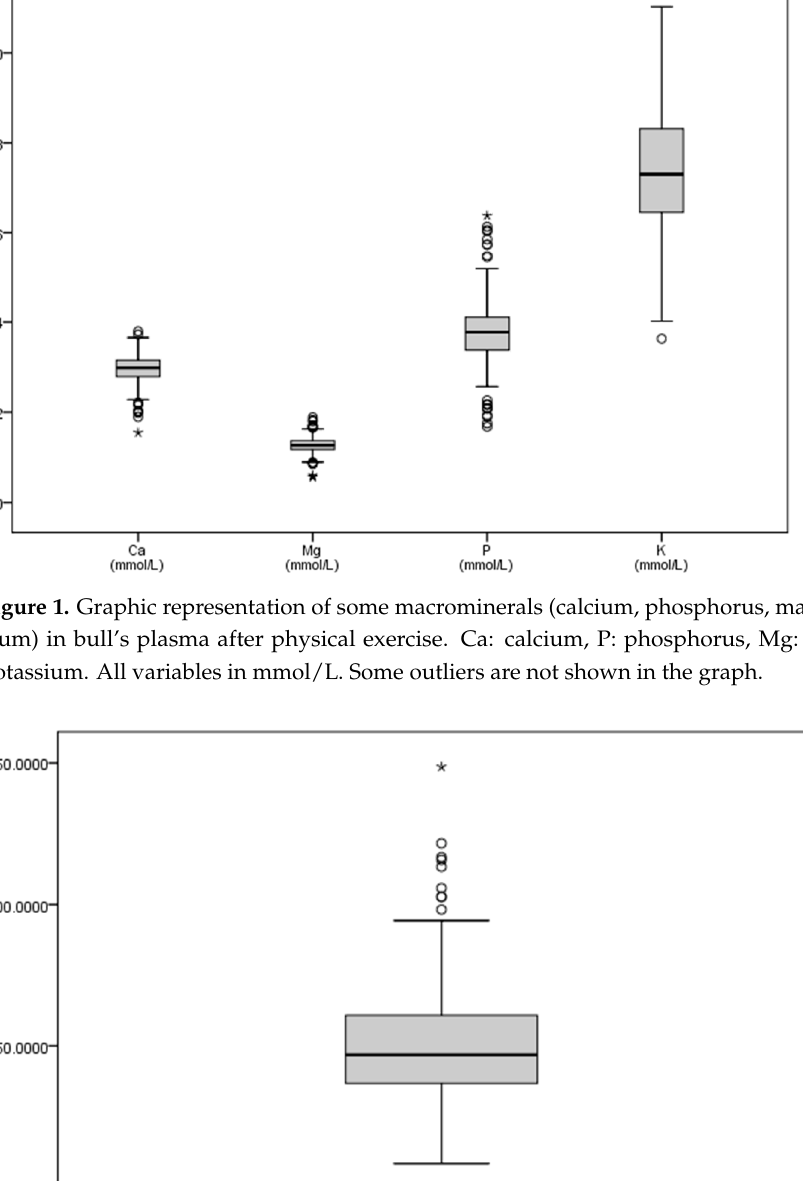
Figure 3. Graphic representation of some trace elements (iron, copper, zinc) in bull’s plasma after physical exercise. Footnotes: Fe: iron, Cu: copper, Zn: zinc. All variables in μ mol/L. Some outliers are not shown in the graph.